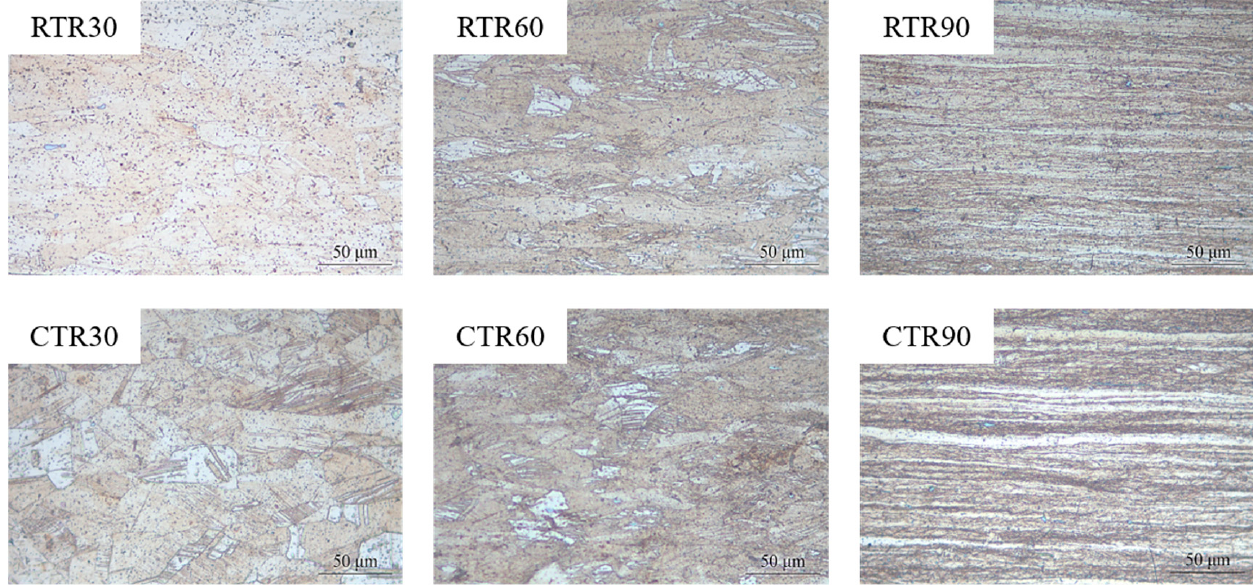
Figure 4. Metallograph of Cu-Ti-Cr-Mg alloy with different rolling conditions.